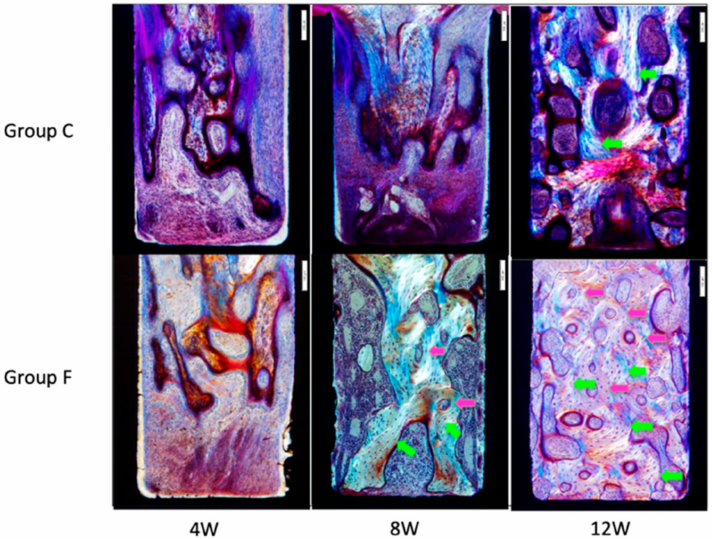
Figure 6. Microscopic images of inner surfaces of slits under polarized light. Greenish-yellow arrows indicate lamellar bone, and pink arrows indicate osteons. Lamellar bone and osteons were visible in Group F at Week 8. At Week 12, Group F showed more lamellar bone and more osteons than Group C.